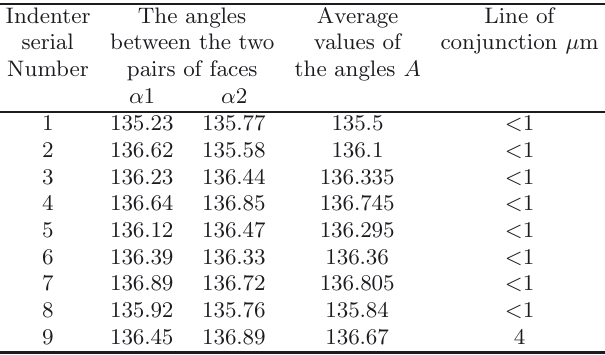
Fig. 3. (Color online) Optical comparator. Table 1. Measured angles of the Vickers